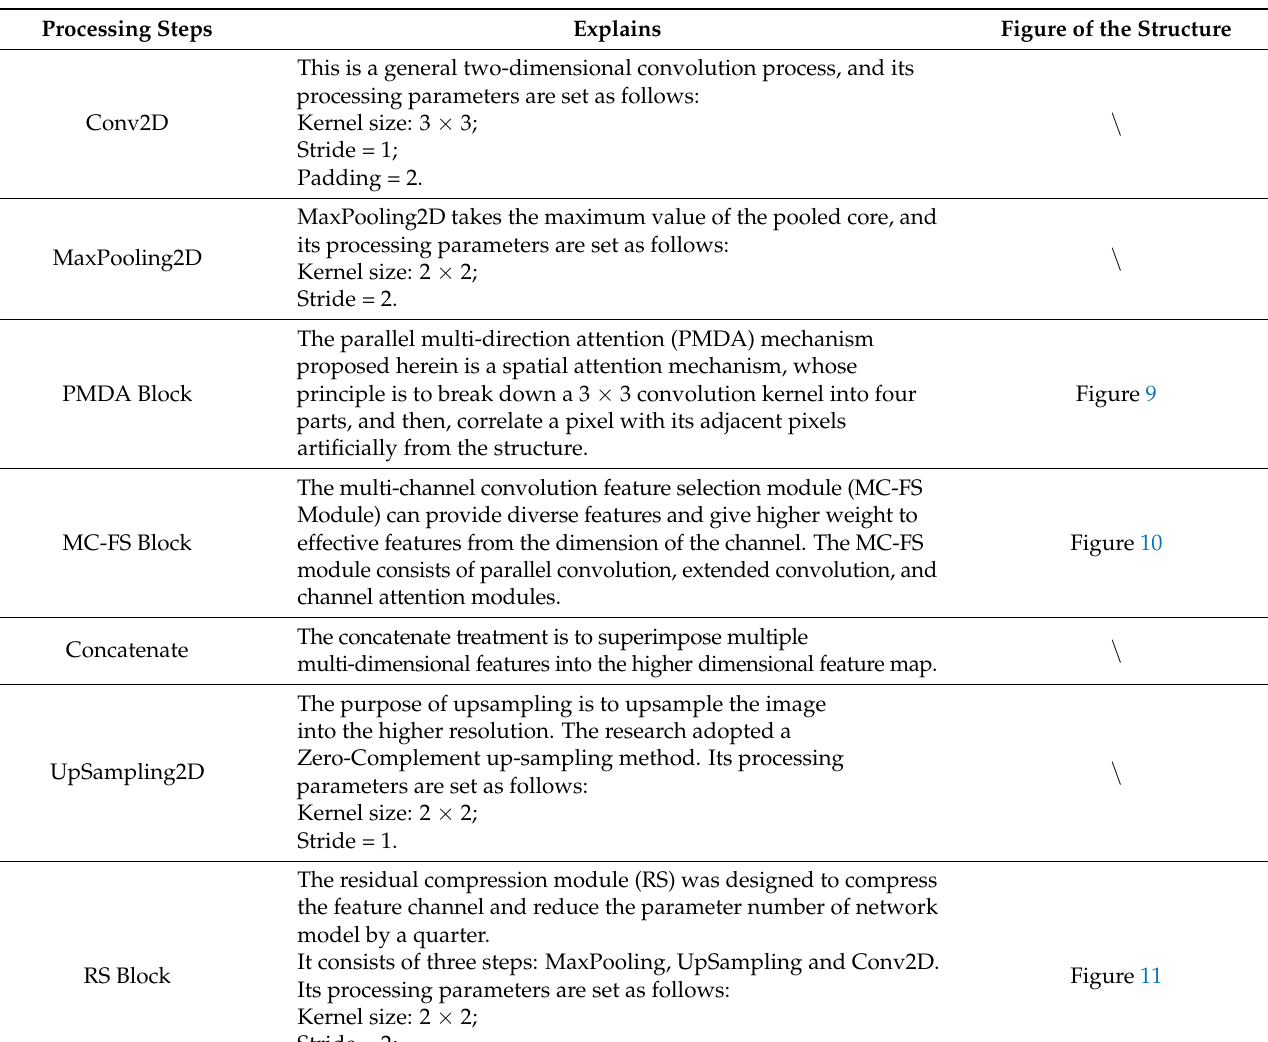
Table 1. The explains of the processing steps of Figure